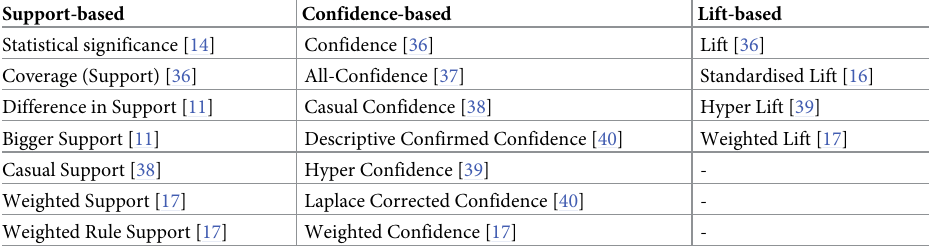
Table 1. A small sample of metrics implemented in DISA. Three types are presented: support-based metrics, confi- dence-based, and